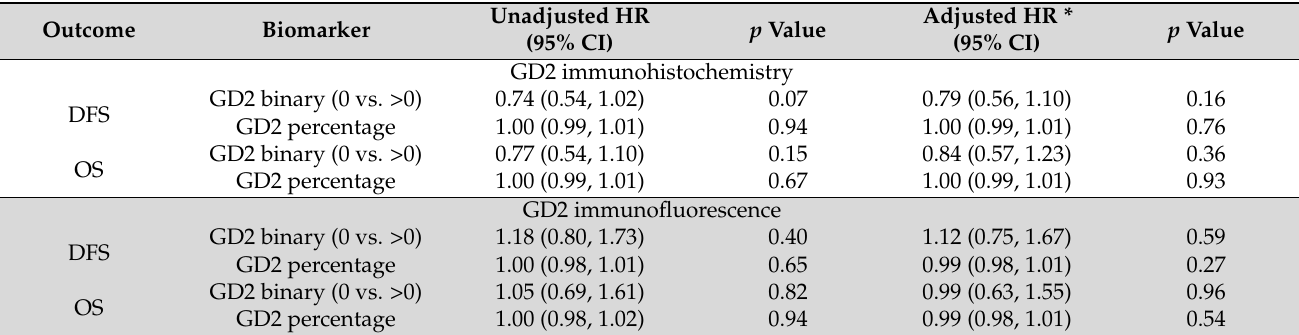
Table 3. Unadjusted and adjusted hazard ratios for GD2 immunohistochemistry and GD2 immunofluorescence values for the outcomes of disease-free survival and overall